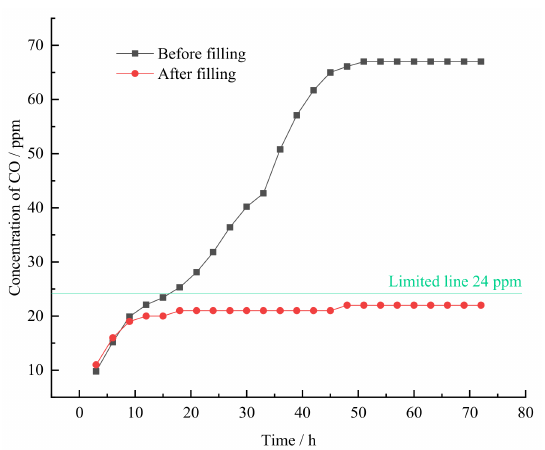
Figure 14. The variation trend of CO concentration in the roadway end before and after the filling